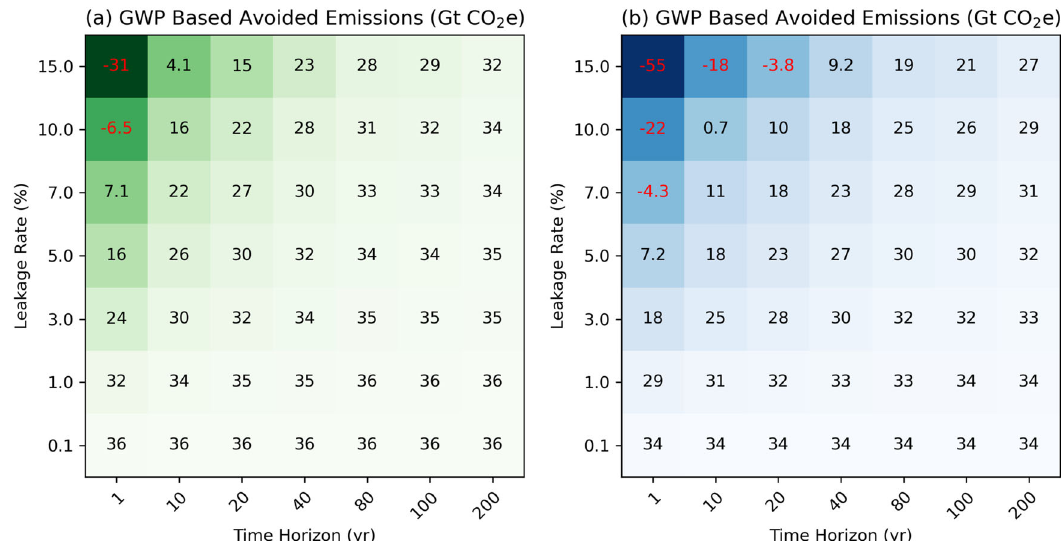
Fig. 5 Abatement of cumulative CO 2 emissions associated with an European energy transition to hydrogen. CO 2 emissions abatement (GtCO 2 e) over the 2030 – 2100 period associated with an european hydrogen economy transition according to the TYNDP2022 scenario and as a function of leakage rate and GWP time-horizon. The hydrogen CO 2 equivalent emissions are calculated considering ( a ) green only, ( b ) blue + green hydrogen according to the TYNDP2022 scenario. The net climate penalty conditions (negative emissions) are provided in red.